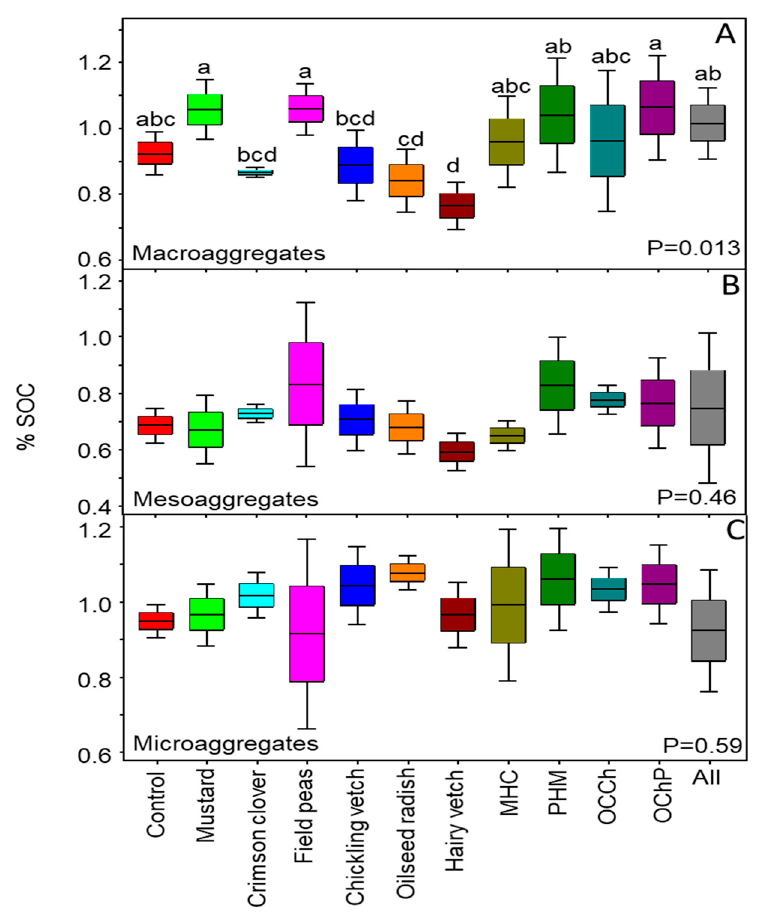
Figure 1. Impact of cover crop monocultures and mixtures on OC contents of different soil macroaggregates ( A ), mesoaggregates ( B ) and microaggregates ( C ). Error bars represent means ± 1SE. The lack of shared letters above the bars indicates a significant difference.